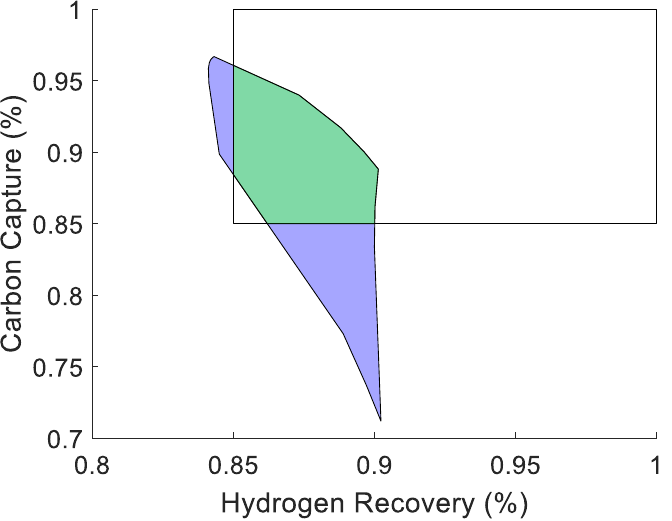
Figure 15. The AOS of the optimum 4-mod design is shown (in blue/green). The area of the overlap (green) with the DOS (white) has an OI of 0.176, approximately a 37% improvement from the base case.